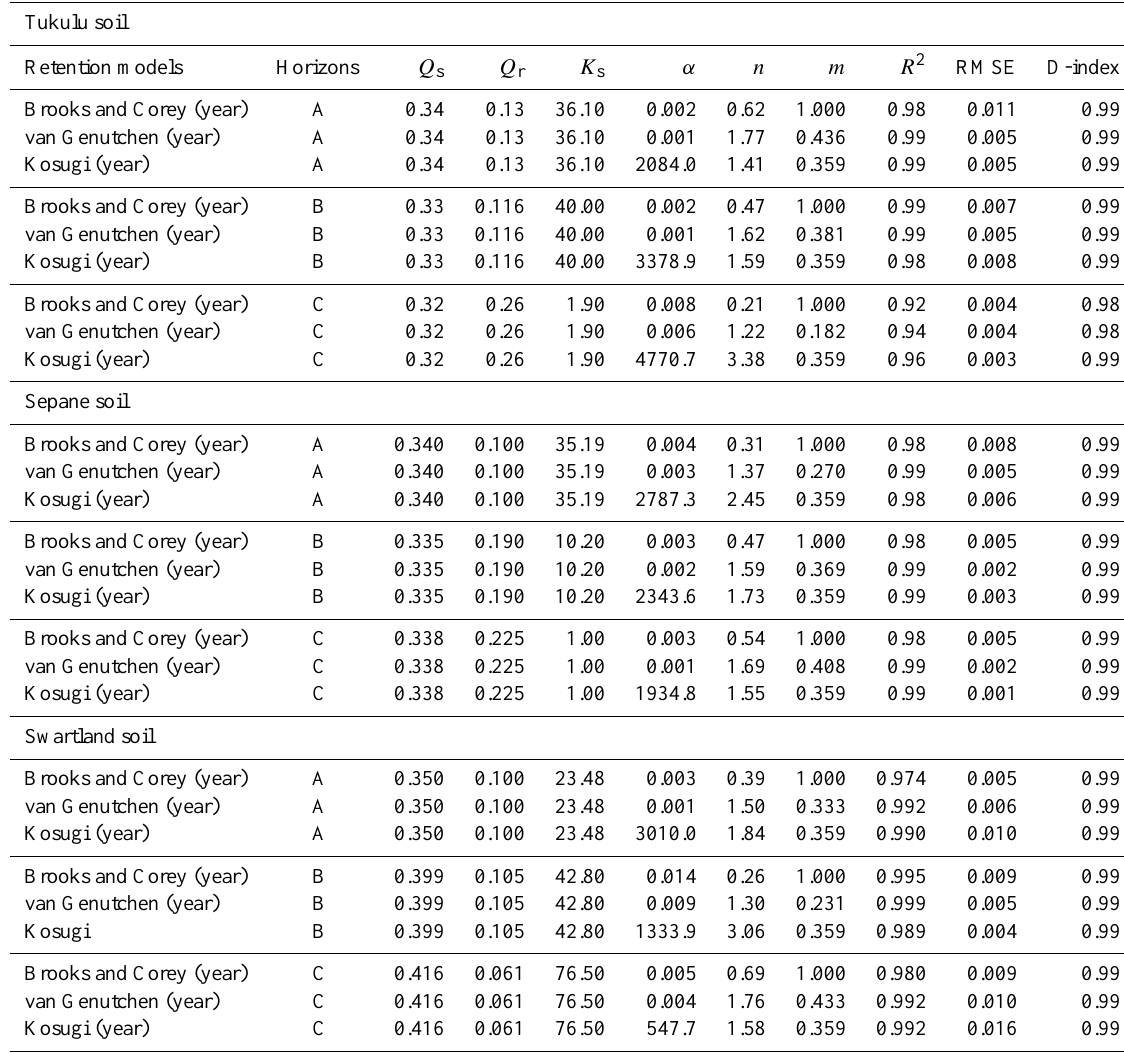
Table 2. Fitting models’ hydraulic parameters of the SWCC for the Tukulu, Sepane and Swartland soil. Tukulu soil Retention models Horizons